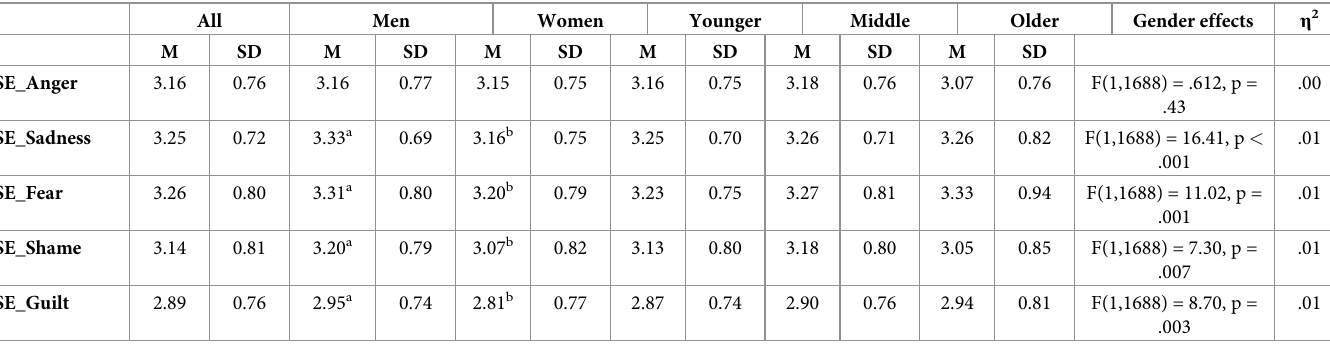
Table 3. Gender and age differences in the five subscales of the MNESRES in a Spanish context. All